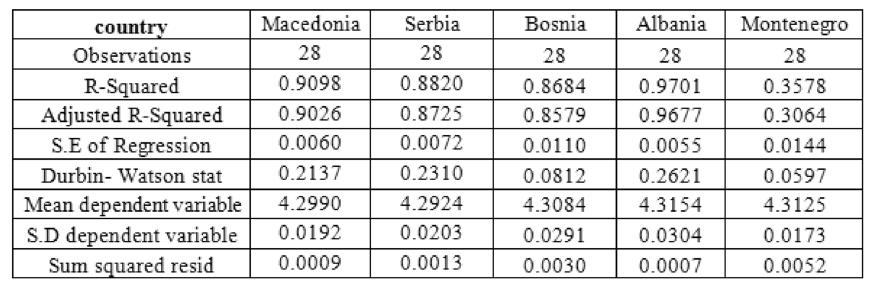
Table 2 Results of FIML method for Life expectancy at birth for Macedonia, Serbia, Bosnia, Albania and